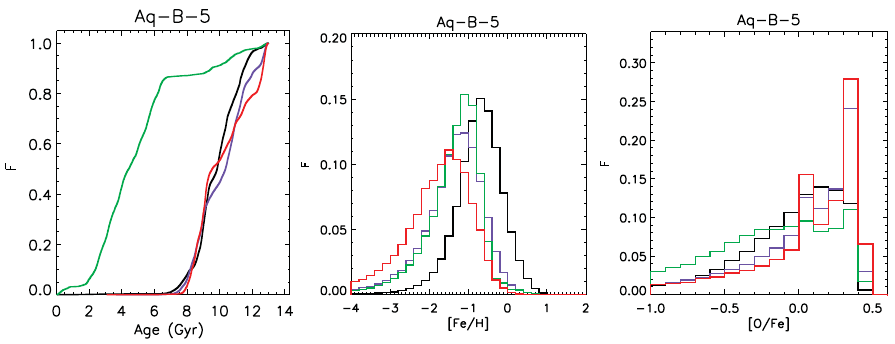
Figure 2. Cumulative stellar mass as a function of age and distributions of [Fe/H] and [O/Fe] for stars in the disc (green), central spheroid (black), inner halo (violet) and outer halo (red) of a typical Aquarius halo.